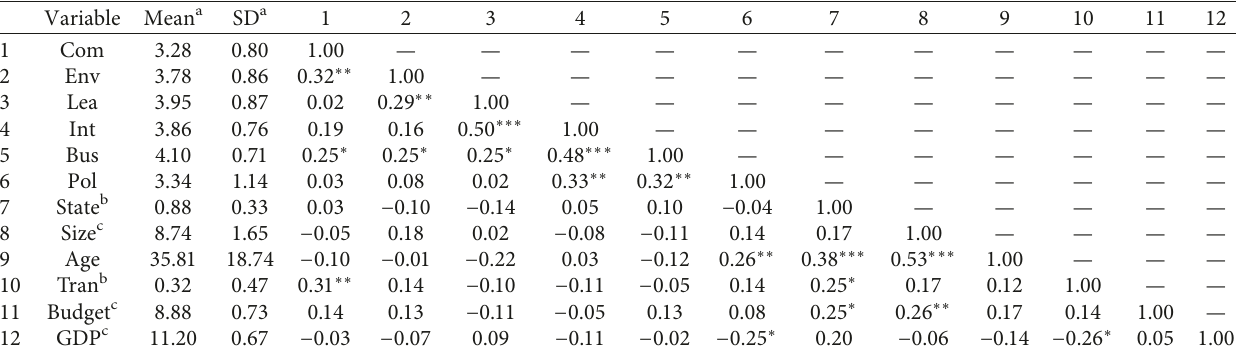
Table 3: Means, standard deviations, and correlations of regression variables.